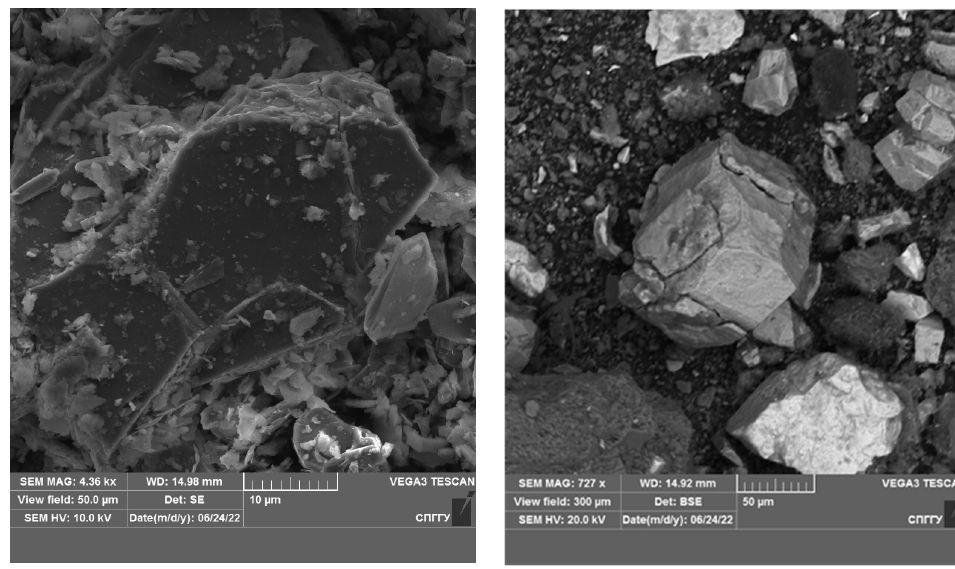
Figure 13. Microphotograph of DOS sample after treatment with liquid nitrogen.